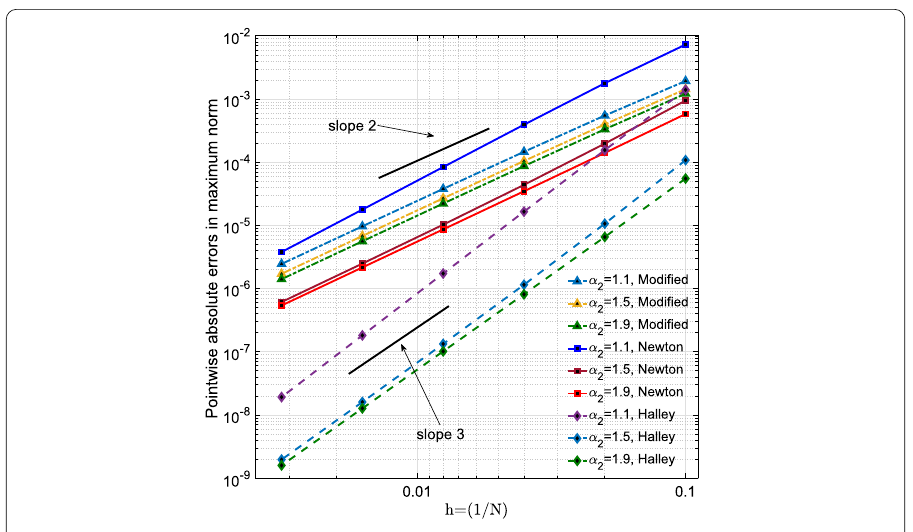
Figure 6 Pointwise absolute errors in maximum norm of Example 4.5 versus the time step h when α 2 = 1.1,1.5,1.9. Graphs demonstrate that computed convergence profiles are nearly O ( h 2 ) for Newton’s and modified integral discretization scheme [21], O ( h 3 ) for Halley’s method, respectively